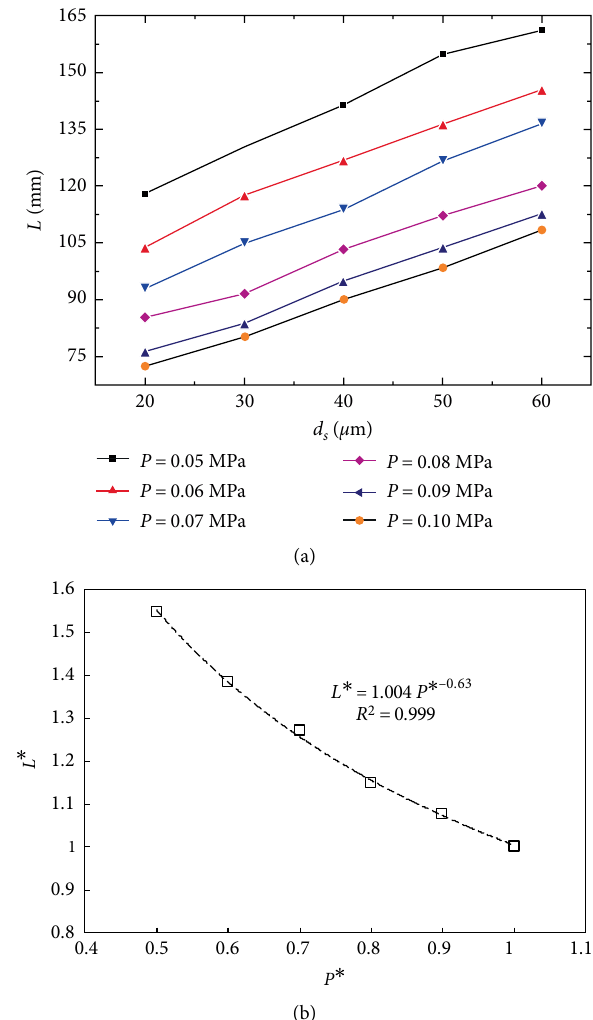
Figure 9: The burning time of the droplets: (a) droplets of different sizes under different atmospheric pressures, (b) the relationship between the average dimensionless burning time of all droplet sizes and atmospheric pressure.